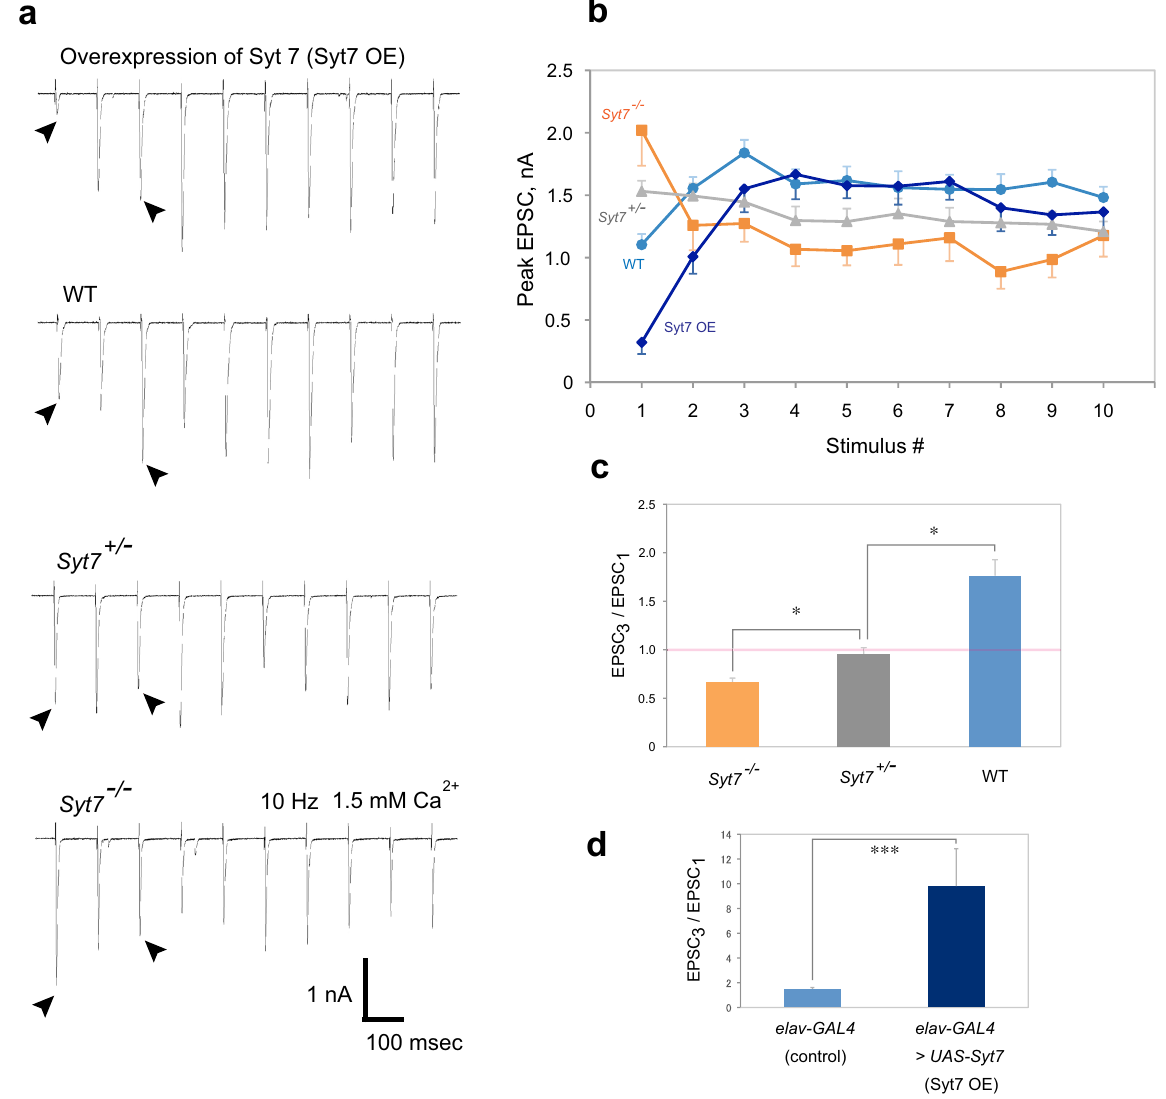
Figure 1. Syt7 switches short-term plasticity from depression to facilitation. ( a ) Representative traces of synaptic currents in response to 10 pulses of 10 Hz repetitive stimulation at 1.5 mM Ca 2+ in embryos overexpressing Syt7 (Syt7 OE, elav-GAL4 > UAS-Syt7 ), WT, Syt7 + /− and Syt7 −/− mutants. Arrowheads indicate comparison of synaptic currents (EPSCs) induced by 1st pulse and 3rd pulse. ( b ) Quantification of 10 Hz stimulation experiments. The number of recorded cells analyzed for each genotype: Syt7 OE, 9; WT, 13; Syt7 + /− , 13; Syt7 −/− , 13. ( c ) Facilitation or depression ratios shown as 3rd pulse-induced EPSC (EPSC 3 )/1st pulse-induced EPSC (EPSC 1 ). WT, Syt7 + /− and Syt7 −/− mutants were analyzed with the Kruskal–Wallis test using a one-way ANOVA by ranks and significant difference between the groups was found (P < 0.0001). *P < 0.05 by Dunn’s post-hoc multiple comparison test between groups. The red line indicates when no facilitation or depression is observed (ratio = 1). ( d ) Facilitation ratio shown as 3rd pulse-induced EPSC (EPSC 3 )/1st pulse-induced EPSC (EPSC recorded cells analyzed for each genotype: elav-GAL4 , 13; elav-GAL4 > UAS-Syt7 , 9. Error bars are